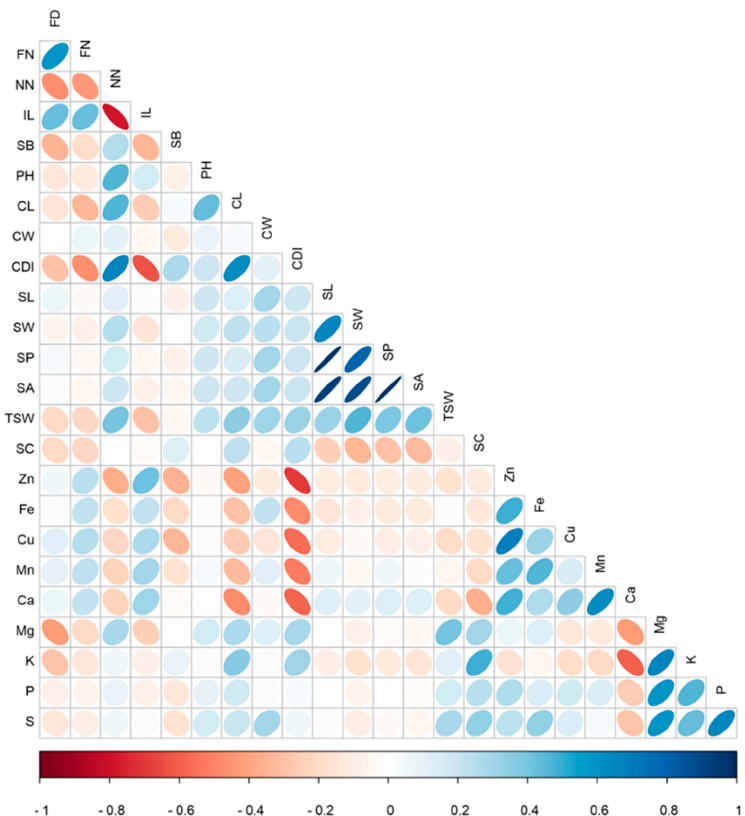
Figure 2. Person correlation matrix in the F 2 population (S-91 × S-297) between the phenotypic traits: FD, flowering date; FN, First flowering node; NN, number of nodes; IL, internode length; SB, number of secondary branches; PH, plant height; CL, capsule length; CW, capsule width; CDI, capsule dehiscence index; SL, seed length; SW, seed width; SP, seed perimeter; SA, seed area; TSW, thousand seed weight; SC, seed color; Zn, zinc; Fe, iron; Cu, copper; Mn, manganese; Ca, calcium; Mg, magnesium; K, potassium; P, phosphorus; and S, sulfur. Colors indicate level of correlation (r) from positive correlation (blue) to negative (red). Circle size indicates the level of significance (Data can be found in Table S5).